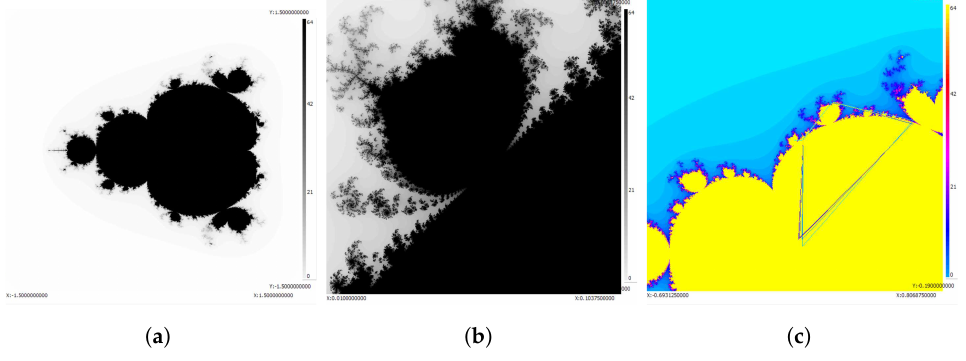
Figure 4. The Mandelbrot set using B 4,0.5 ( x ) iterated 64 times. ( a ) B 4,0.5 ( x ) ; ( b ) Enlarged view; ( c ) Periodic critical orbit.